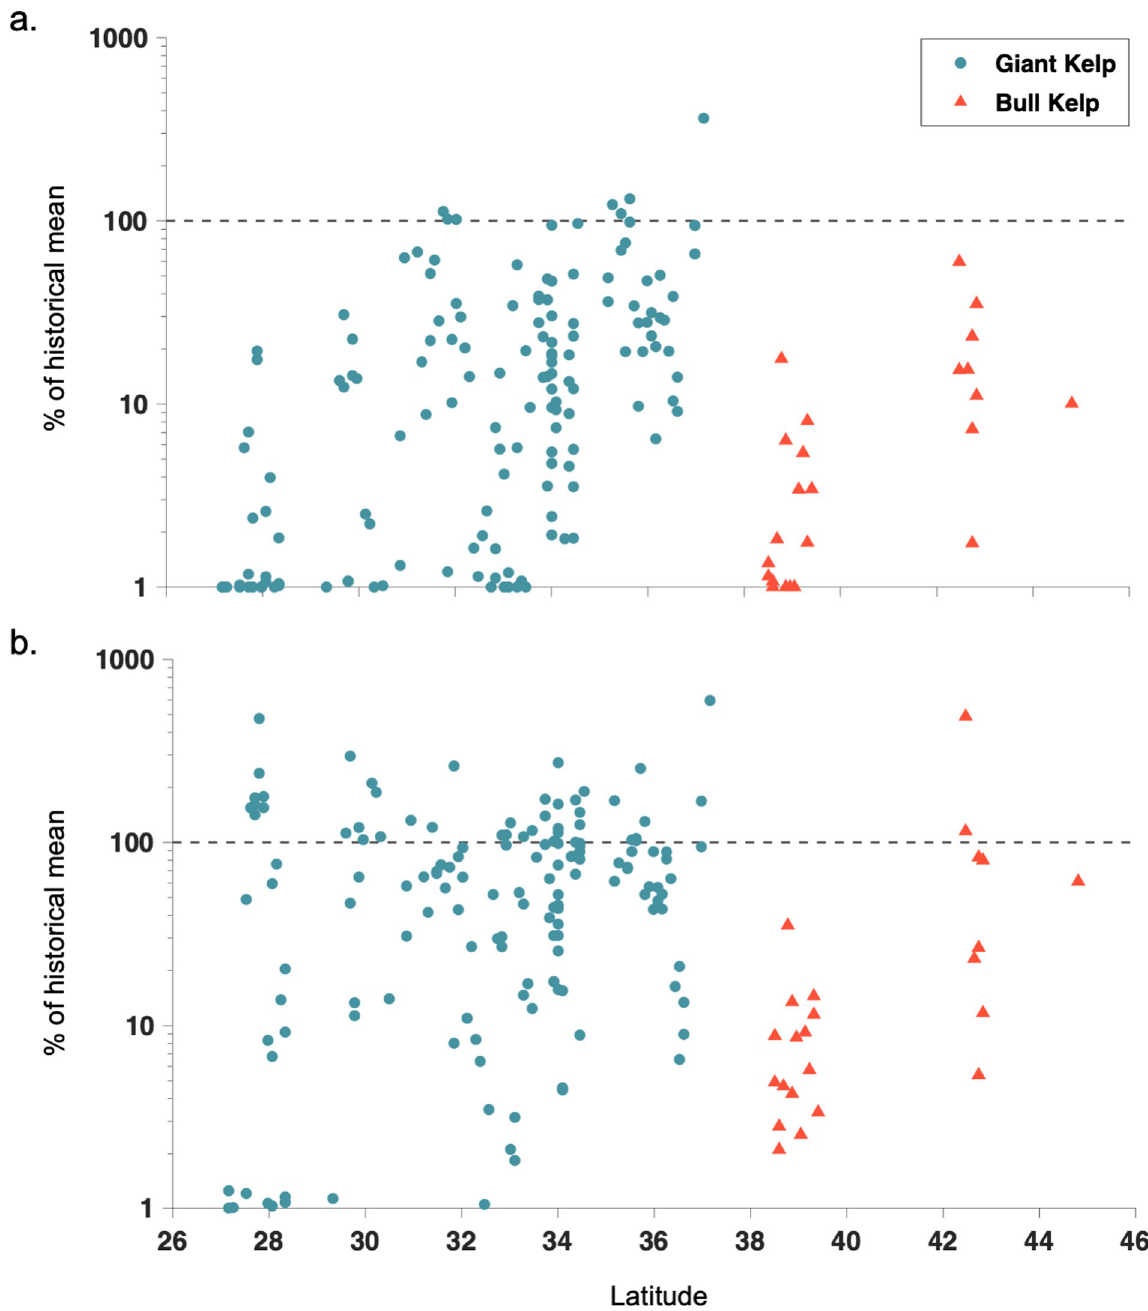
Fig 4. Latitudinal trends in response and recovery. Scatter plots of kelp canopy a.) response to and b.) recovery from the 2014 to 2016 marine heatwave events compared to the historical mean (1984 to 2013) for each 10 x 10 km cell. Areas dominated by giant kelp canopy are shown as blue circles and areas dominated by bull kelp canopy are shown as red triangles. Black horizontal dashed lines show the historical mean. Note that the y-axes are on a log scale.